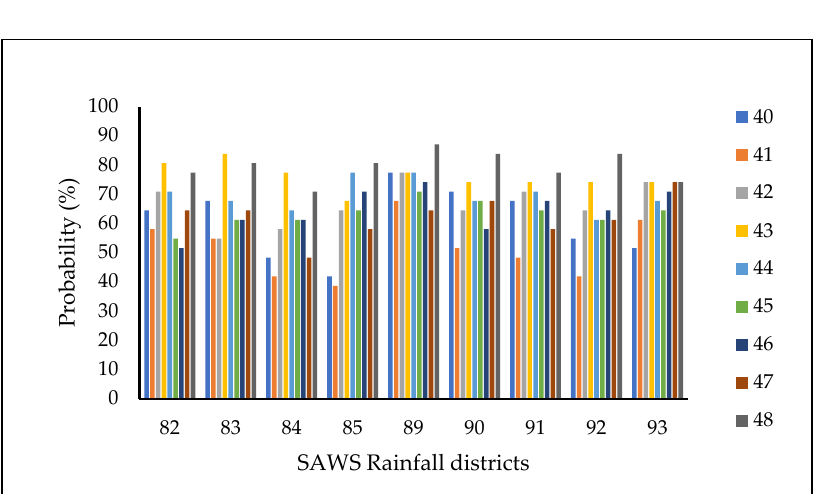
Figure 4. Initial dry ‐ spell probability for selected SAWS rainfall districts from 1985 to 2015 during pentad 40 to 48.